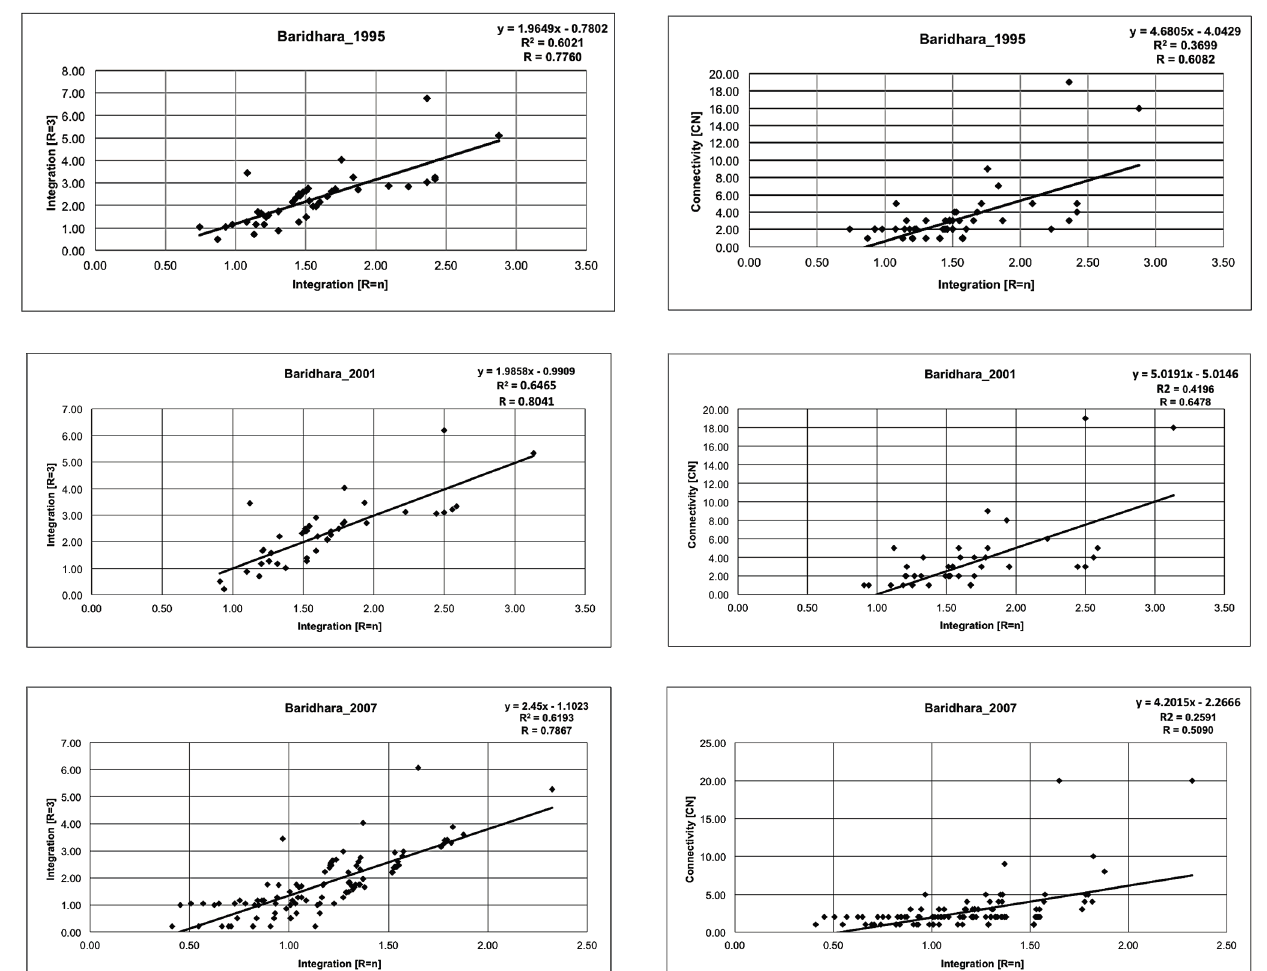
Figure 14. Scatter of correlation between local and global measures (R n -R3) and (R n -CN) of ward 18